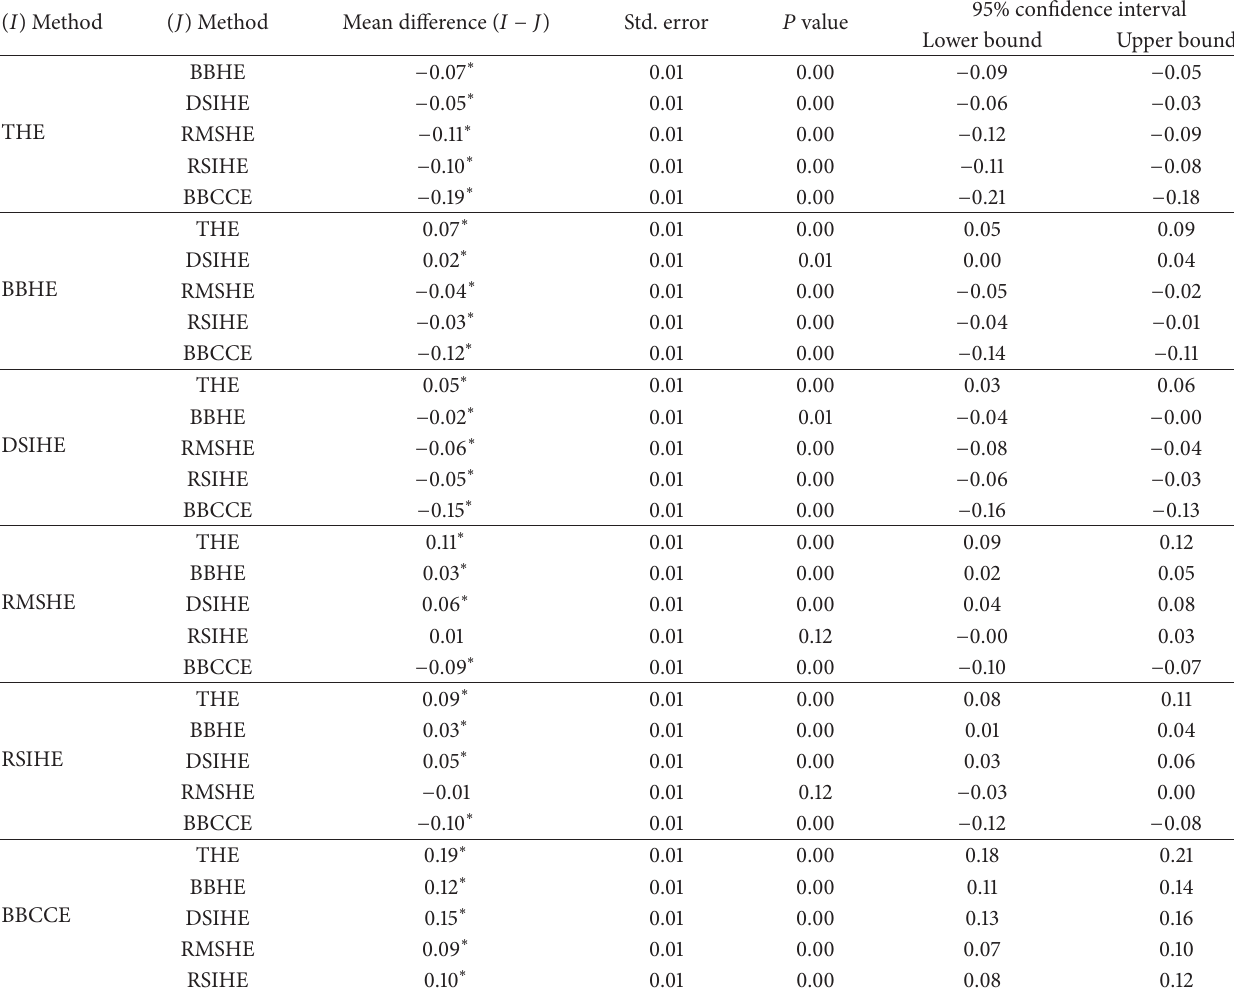
Table 7: Categorization of different methods using Fisher’s Least Significance Difference (LSD) for FSIM. ( 𝐼 ) Method